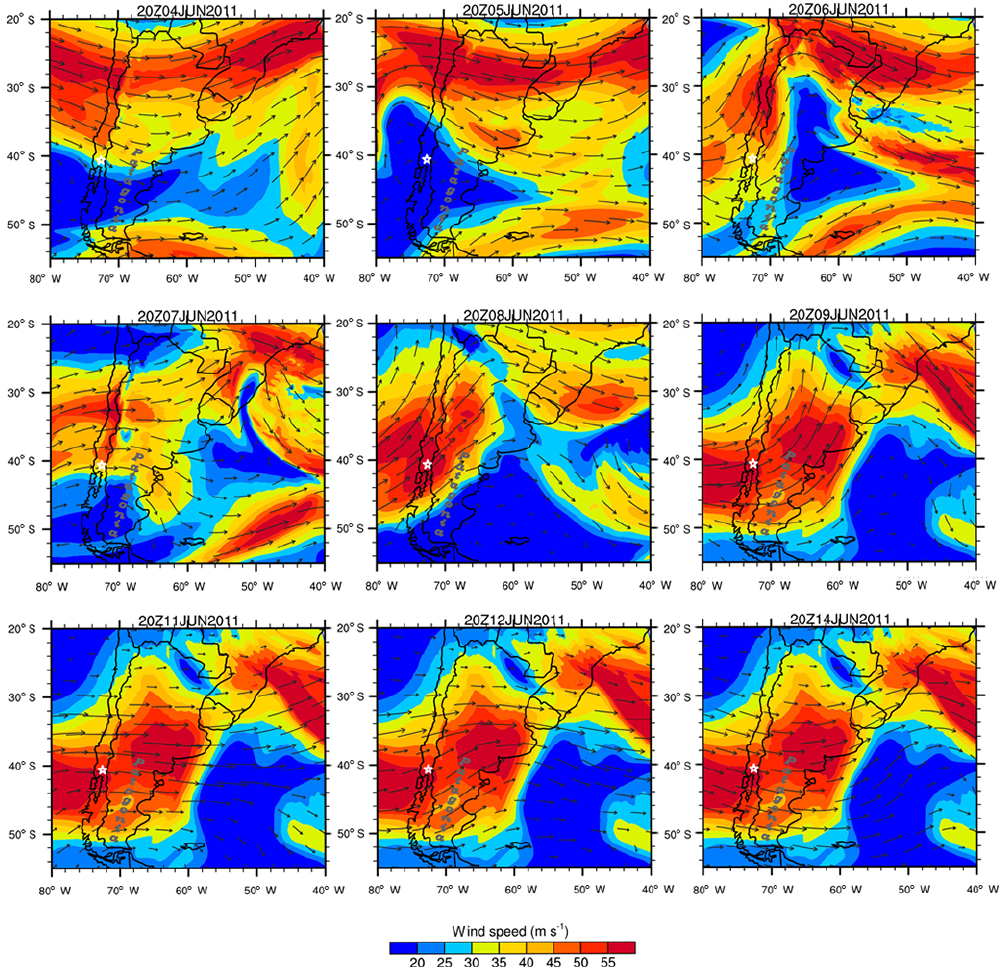
Figure 2. Meteorological synoptic situation during the first 2 weeks (4–14 June) of the 2011 Caulle (white star) activity over South America. Plots show the direction (vector) and velocity (contours ms − 1 ) of the wind at 9100ma.g.l. (above ground level) (300hPa circa). Meteoro- logical data obtained from the NMMB meteorological forecast driven with ERA-Interim reanalysis at 0.75 ◦ horizontal